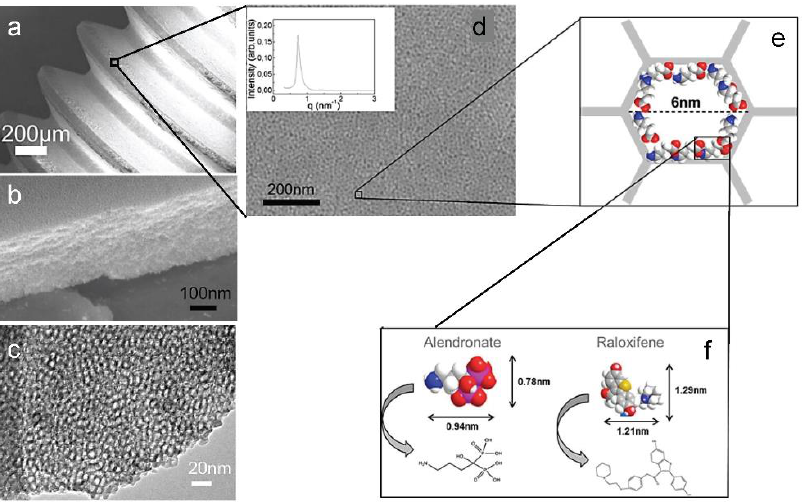
Figure 3. ( a ) SEM image of a screw-shaped titanium implant coated with a mesoporous TiO 2 thin film. ( b ) Cross section of the mesoporous TiO 2 layer. ( c ) TEM image of the TiO 2 thin film matrix. ( d ) SEM image of mesoporous implant at a higher magnification; inset shows the synchrotron SAXS pattern for the mesoporous TiO 2 . The schematic illustration in ( e ) shows the pore diameter of 6 nm. The active substances ALN and RLX in ( f ) were absorbed into the porous structure. Adapted from